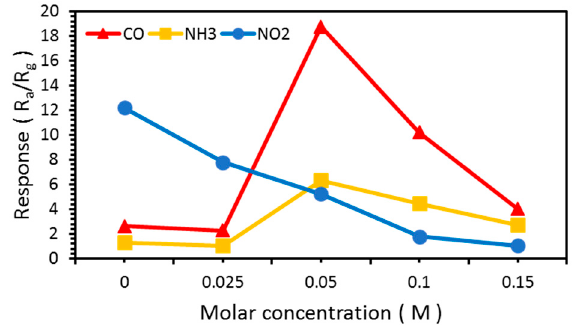
Figure 10. Response of ZnO NW vines to 100 ppm CO and NH 3 at various concentrations of α -Fe 2 O 3 at 300 °C. Table 2. Response at various concentrations of α -Fe 2 O 3 at 300 °C.